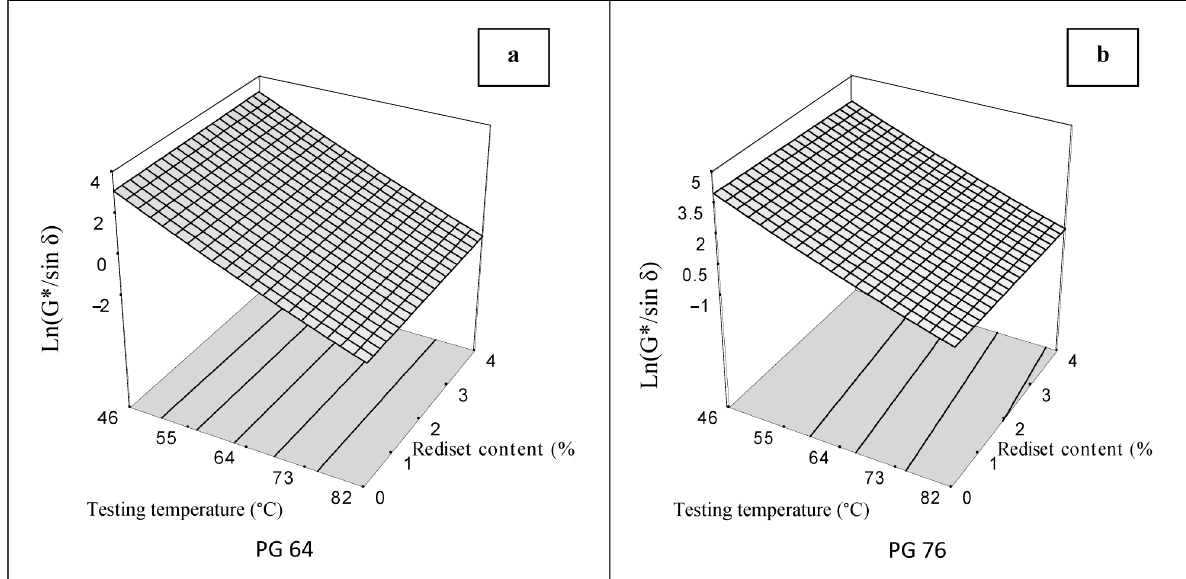
Fig. 6. Plot of response surface for the Ln(G*/sin δ) value for unaged conditions